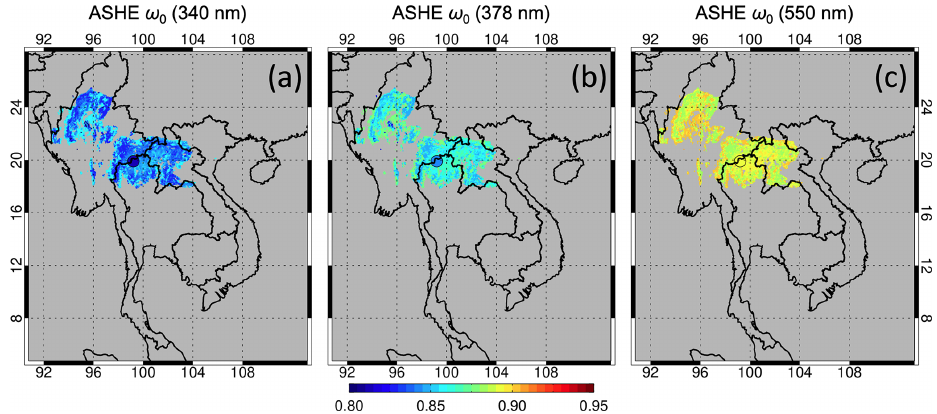
Figure 13. Aerosol single scattering albedo ( ω 0 ) retrieved at (a) 340nm, (b) 378nm, and (c) 550nm from ASHE (Aerosol Single-scattering albedo and Height Estimation; Lee et al., 2021) algorithm on 30 March 2019. Colored circles present values of collocated SMART–s retrievals which are indicated by the color bar at each